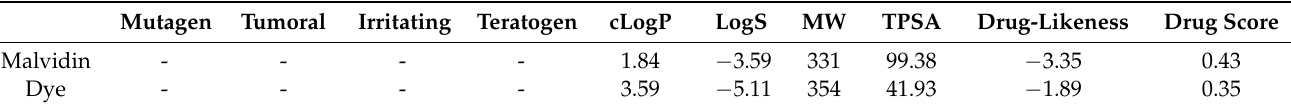
Table 1. Calculated descriptors for malvidin and the synthesized dye